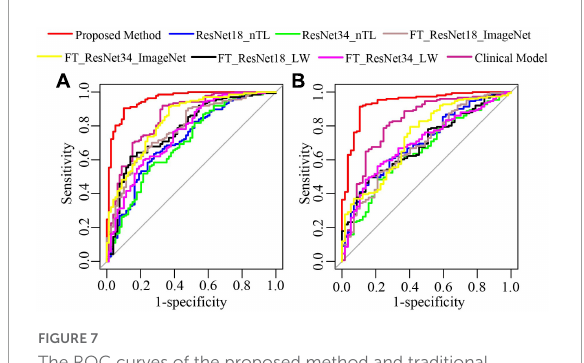
FIGURE7 The ROC curves of the proposed method and traditional methods. (A) ROC of test cohort 1; (B) ROC of test cohort 2.